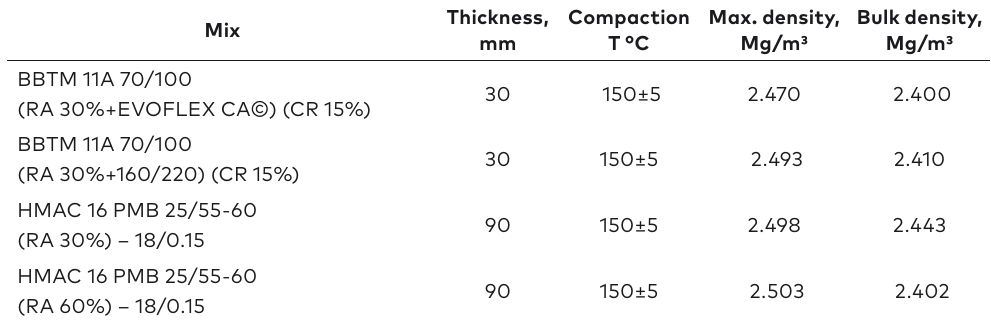
Table 4. Physical properties of research mixtures